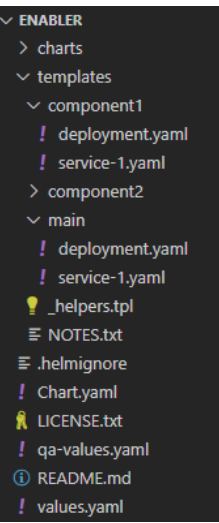
Figure 11. Proposed enablers’ chart